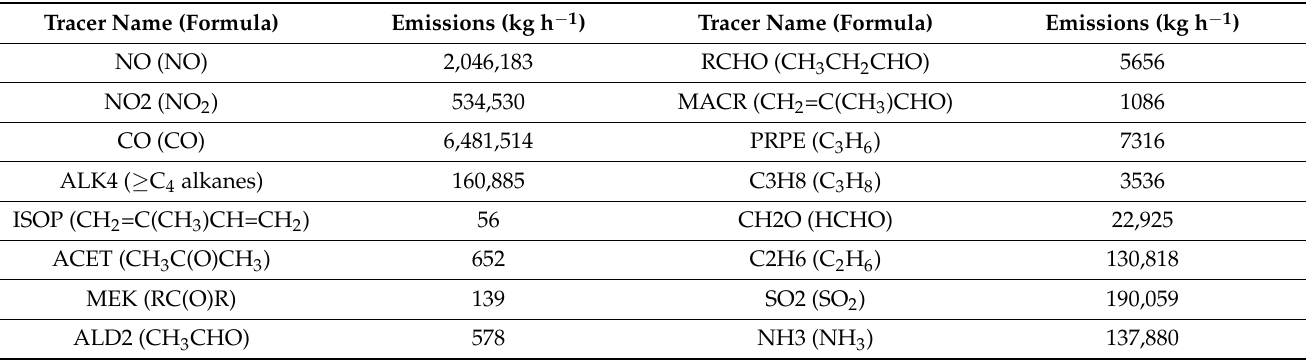
Table 4. Total emissions in the domain used in the coupled computational fluid dynamics (CFD)-chemistry model simulations for the realistic case. Units are kilograms per hour (kg h − 1